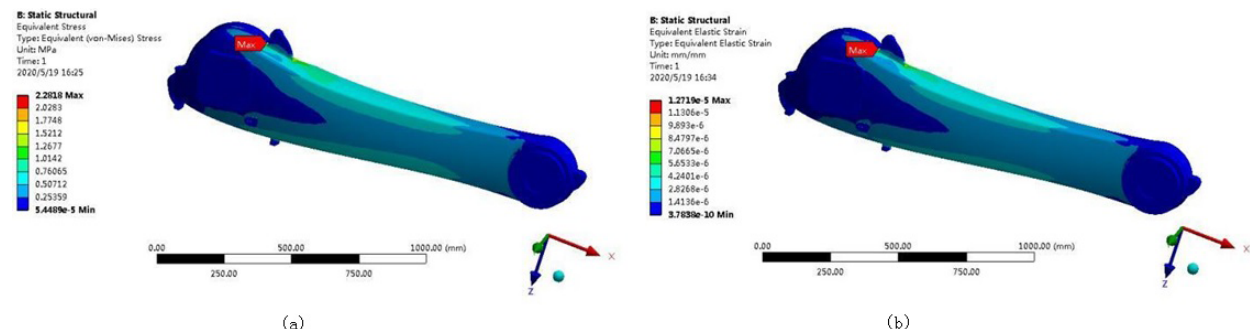
Figure 8. Static cloud diagram of the manipulator forearm model; (a) equivalent stress cloud diagram; (b) equivalent strain cloud diagram.